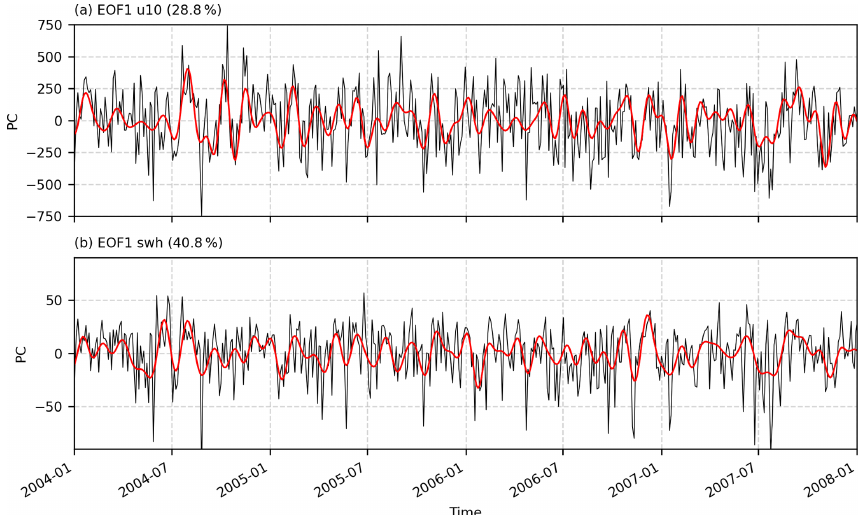
Figure 3. PC of the (a) EOF1 of u 10 and (b) EOF1 of the swh. Black lines represent the PC of the anomaly fields, and red lines represent the PC of filtered anomaly fields. The percentages represent the explained variance of EOF modes considering the anomalies fields.